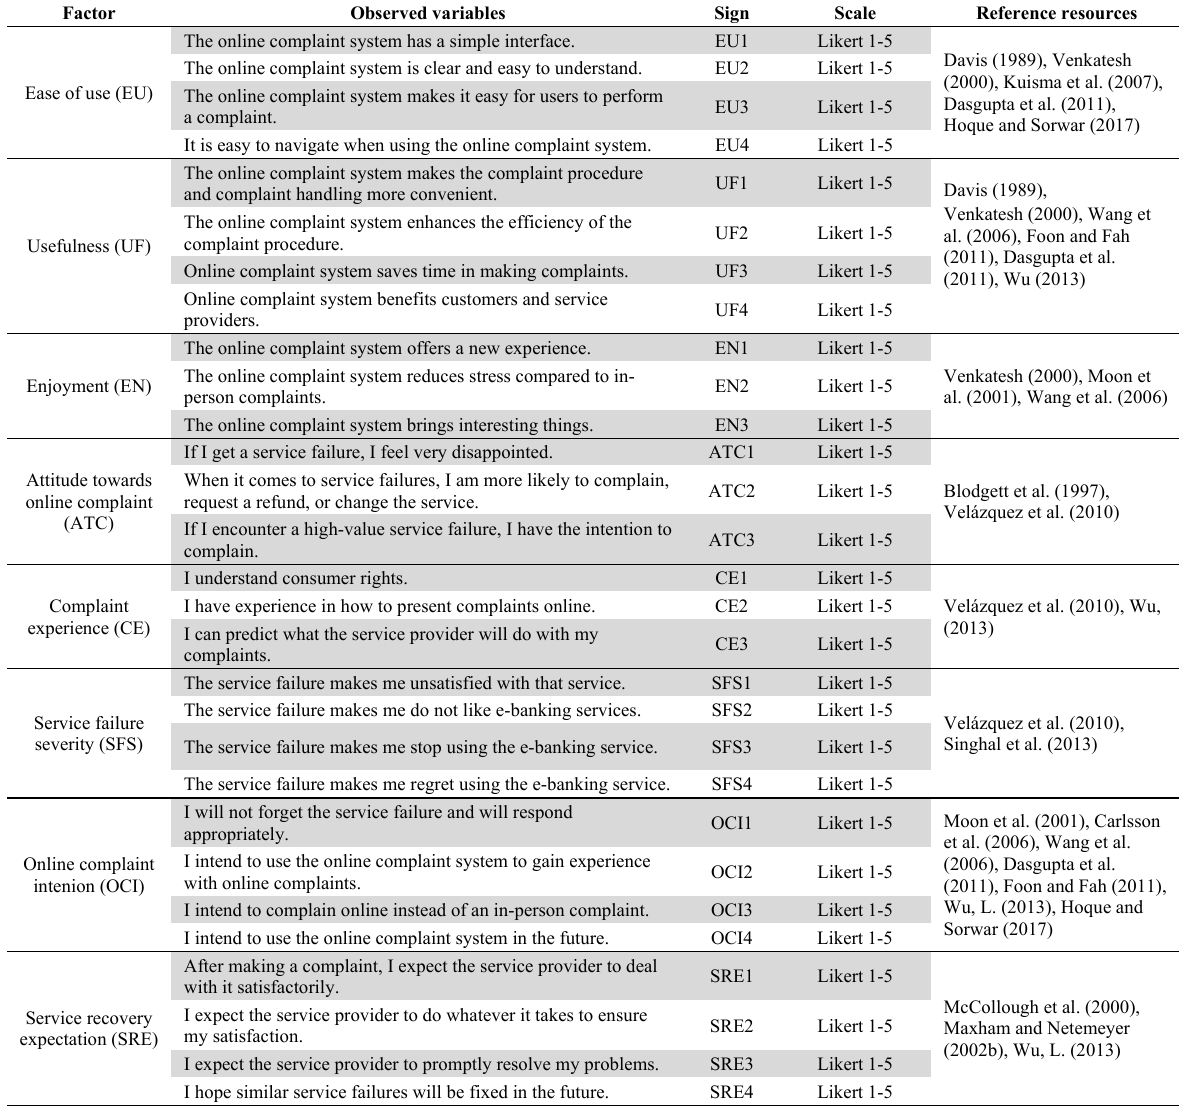
Interpretation of observed variables in the research model Factor Observed variables Sign Scale Reference